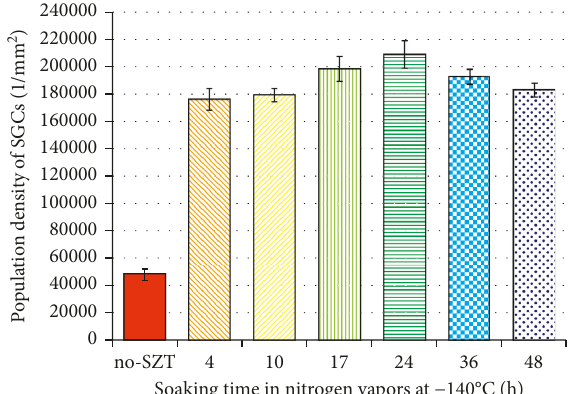
Figure 5: Population density of SGCs for samples processed by CHT and SZT, with various soaking times in nitrogen vapors at 140 ° C. −